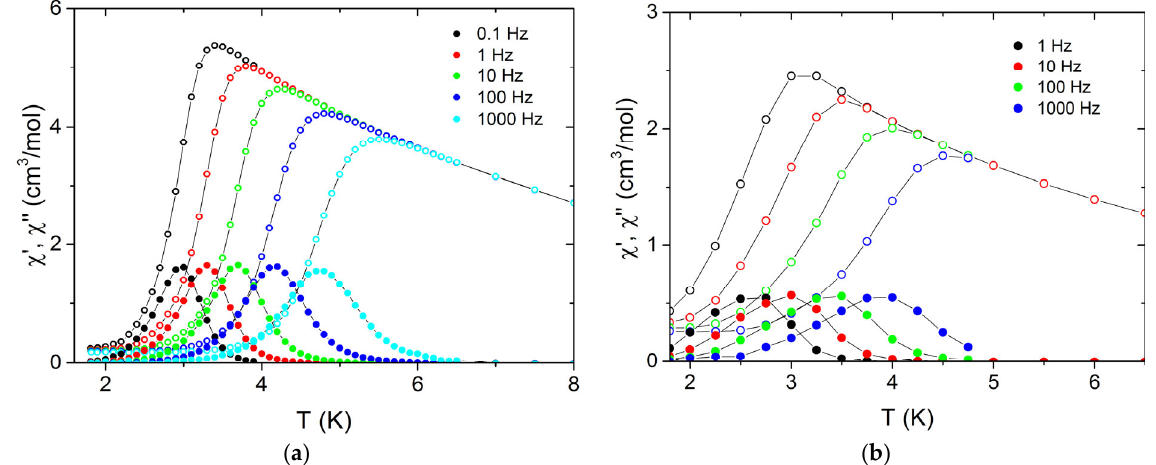
Molecules 2023 , 28 , x FOR PEER REVIEW Figure 6. Real (empty dots) and imaginary (full dots) parts of ac susceptibility for 1 ( a ) and 2 ( b ) measured at different ac frequencies using H ac = 3 Oe in zero dc field. Solid lines are to guide the eye. For a deeper understanding of the relaxation processes, the ac susceptibility was studied over the frequency range 0.1–1000 Hz at low temperatures. These data are presented in Figure 7. The frequency dependent susceptibility measured at constant temperatures was used to determine the relaxation time at each temperature. The generalized Debye relaxation model [137] was used to fit χ ’( υ ) and χ ’’( υ ) simultaneously (Equation (3)) (solid lines in Figure 7).